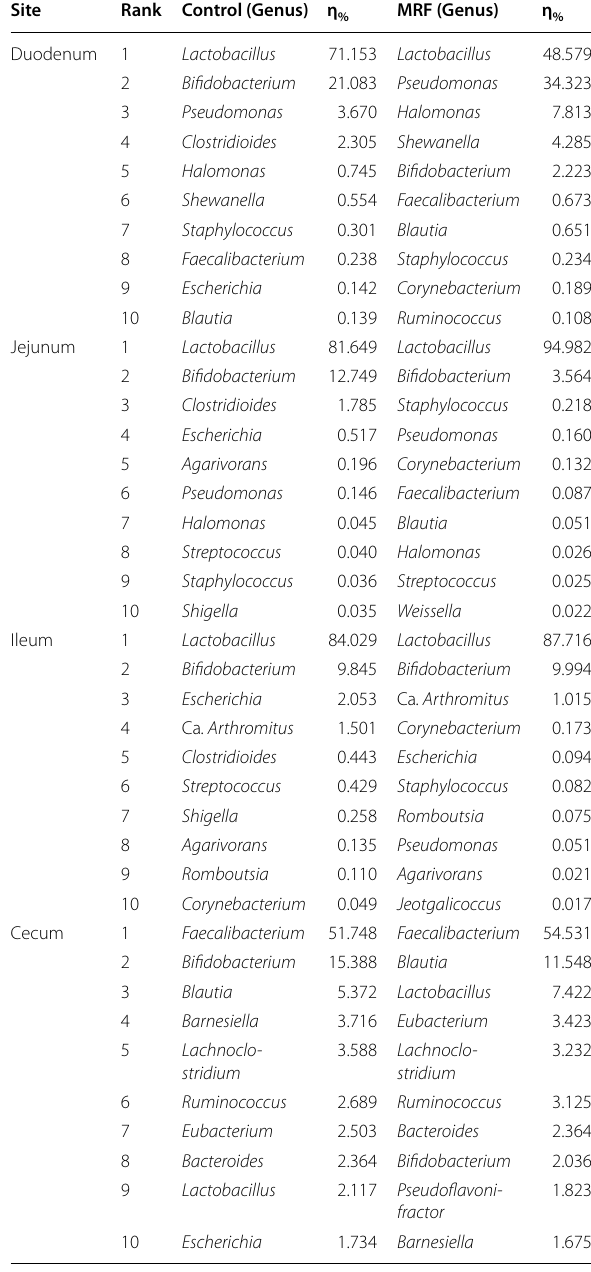
Median relative abundances (η % ) were used to determine the rank of each taxon in each subset